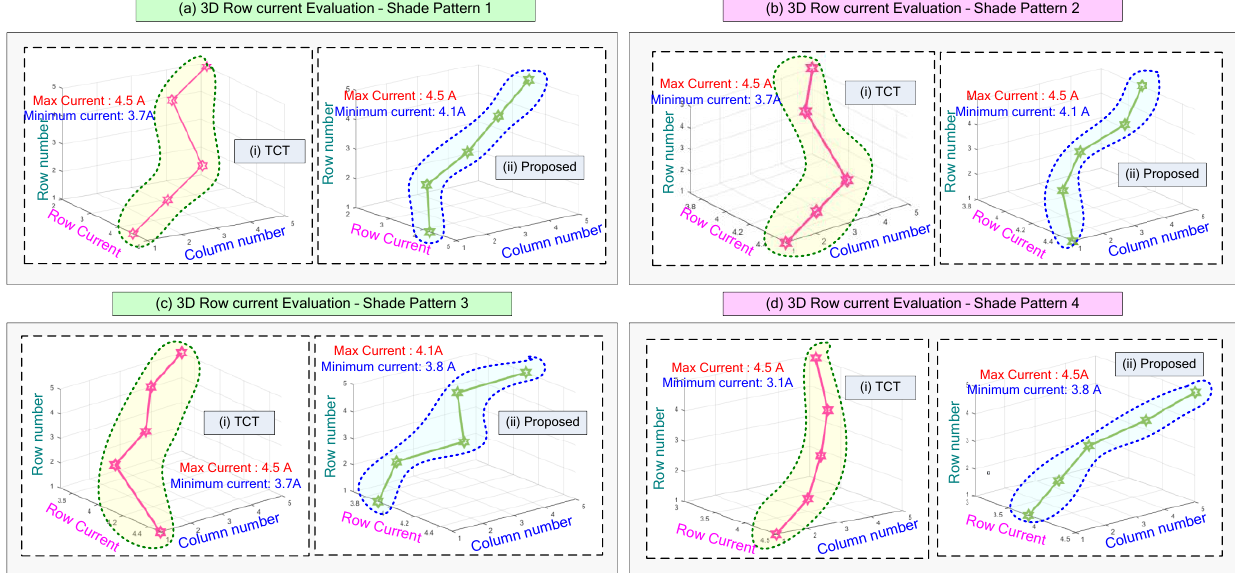
Figure 7. 3D row current evaluation for TCT and the proposed method forshade patterns (1 – 4).